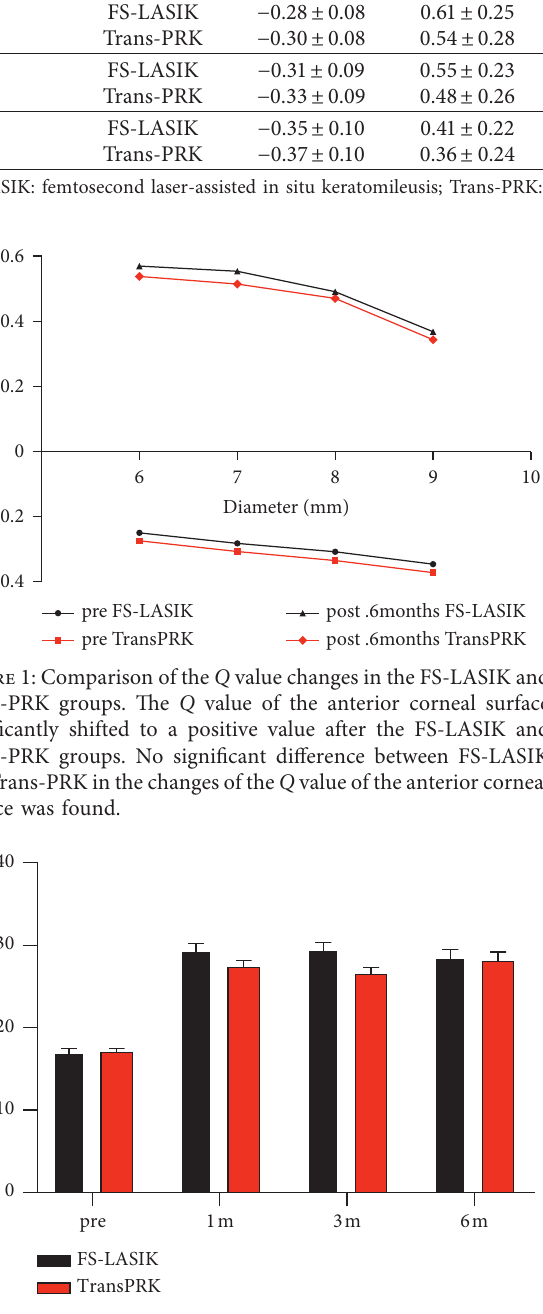
Figure 2: Preoperative and postoperative ISV values in the FS- LASIK and Trans-PRK groups. The ISV of the corneal surface significantly increased after the FS-LASIK and Trans-PRK groups. No significant difference between FS-LASIK and Trans-PRK in the changes of the ISV was found. ISV, index of surface